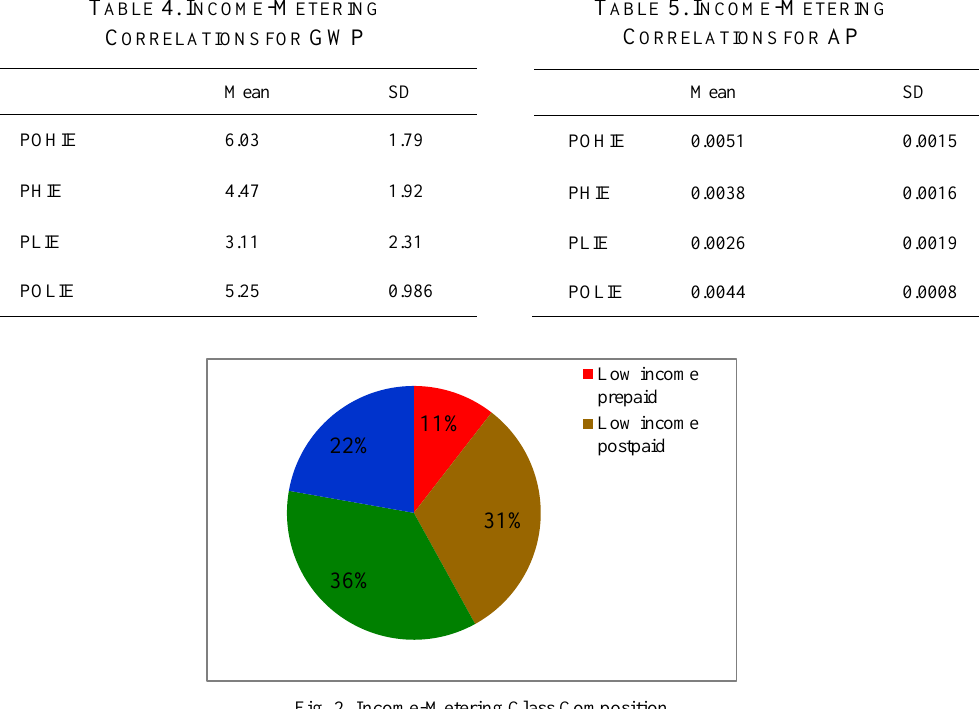
Fig. 2. Income-Metering Class